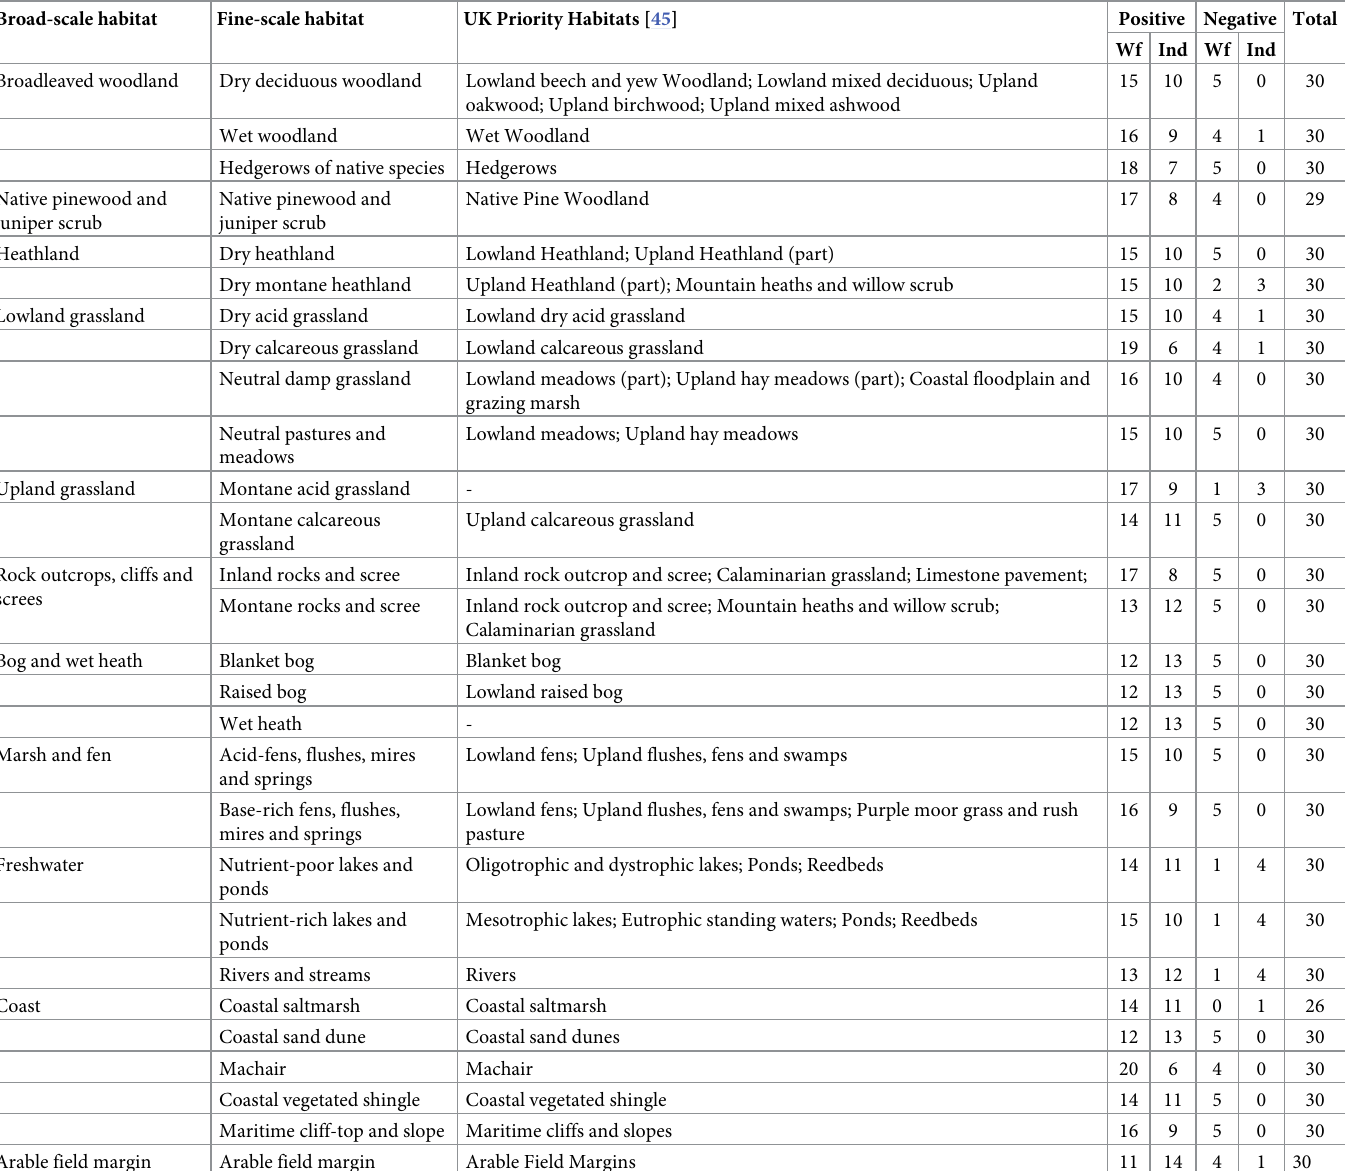
Table 1. Broad and fine-scale habitats covered by the National Plant Monitoring Scheme (NPMS). Broad-scale